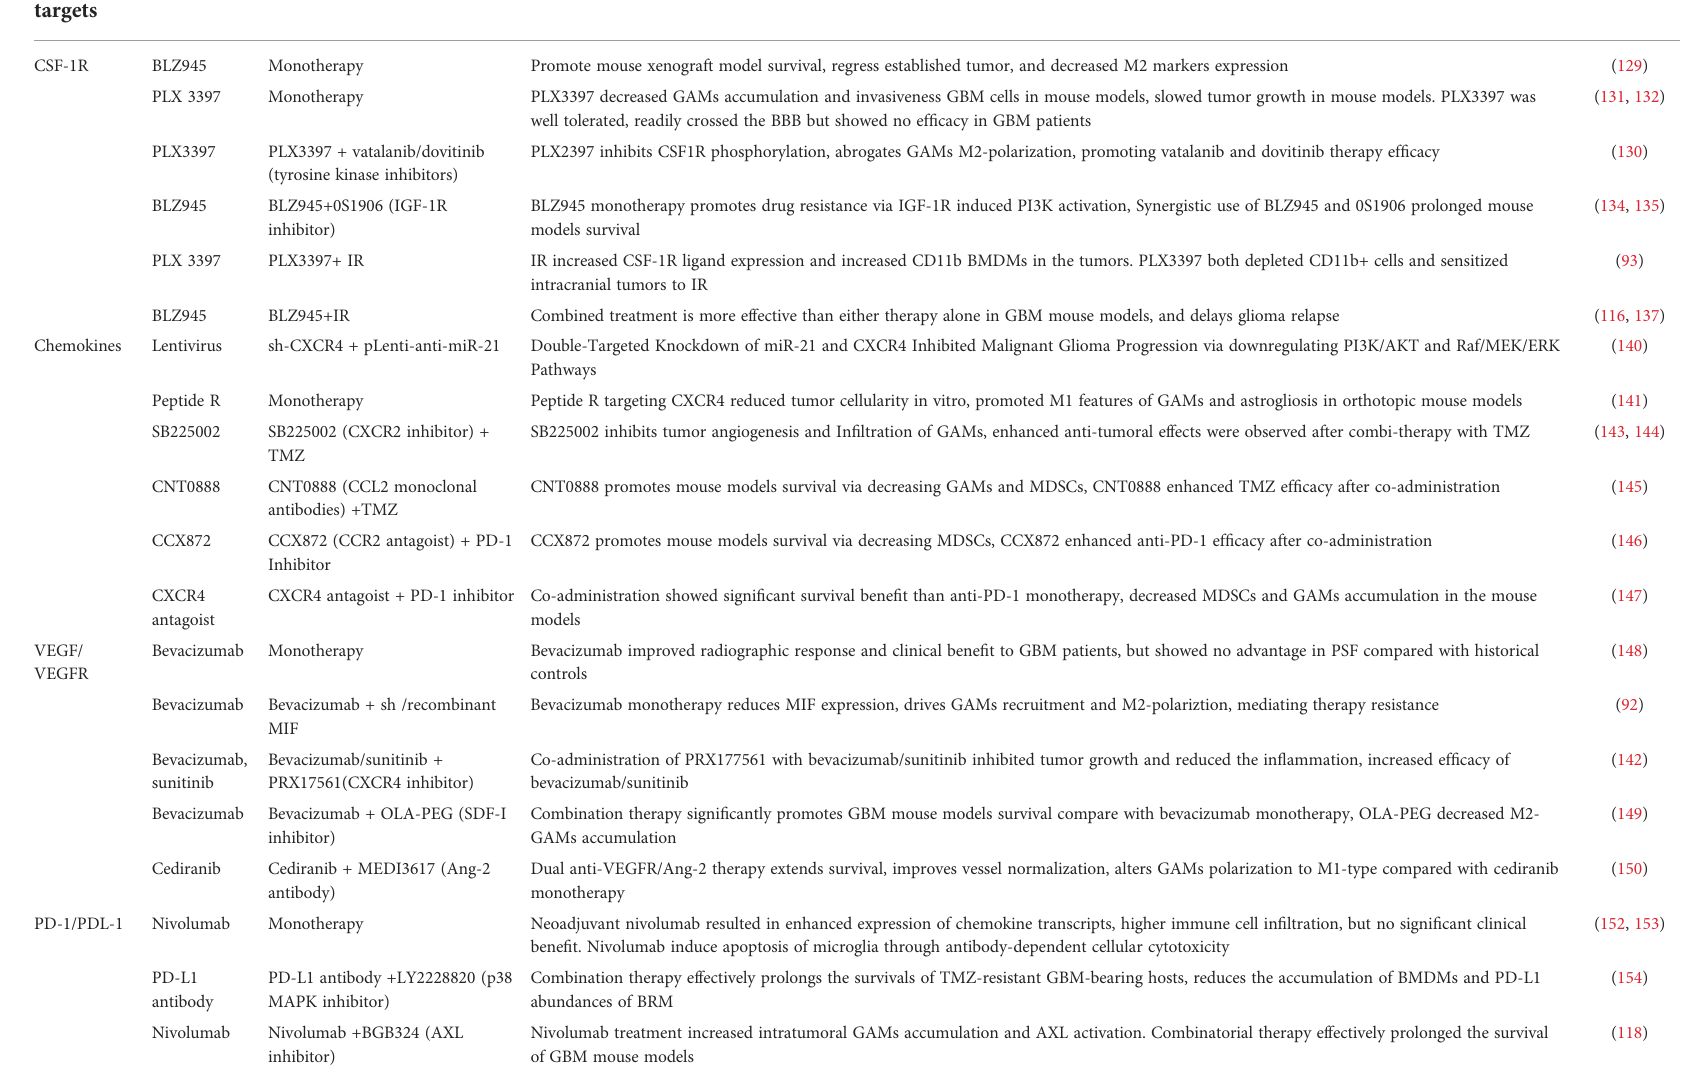
TABLE 2 Research progress of targeting GAMs in the treatment of